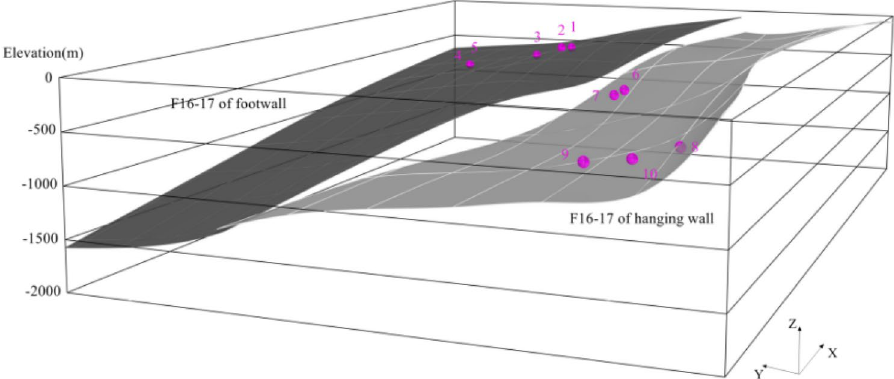
Figure 4. Diagram of coal seam occurrence of F 16-17 . The pink bullets indicate the in-situ stress points (as in Fig. 3).